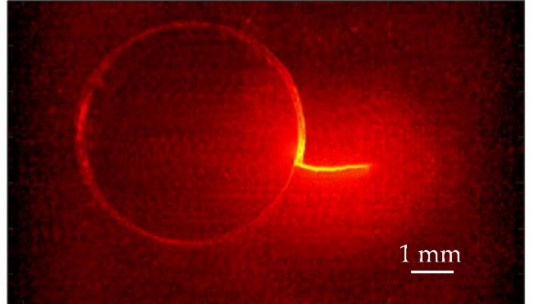
Figure 8. Combined first-derivative thermographic image of the